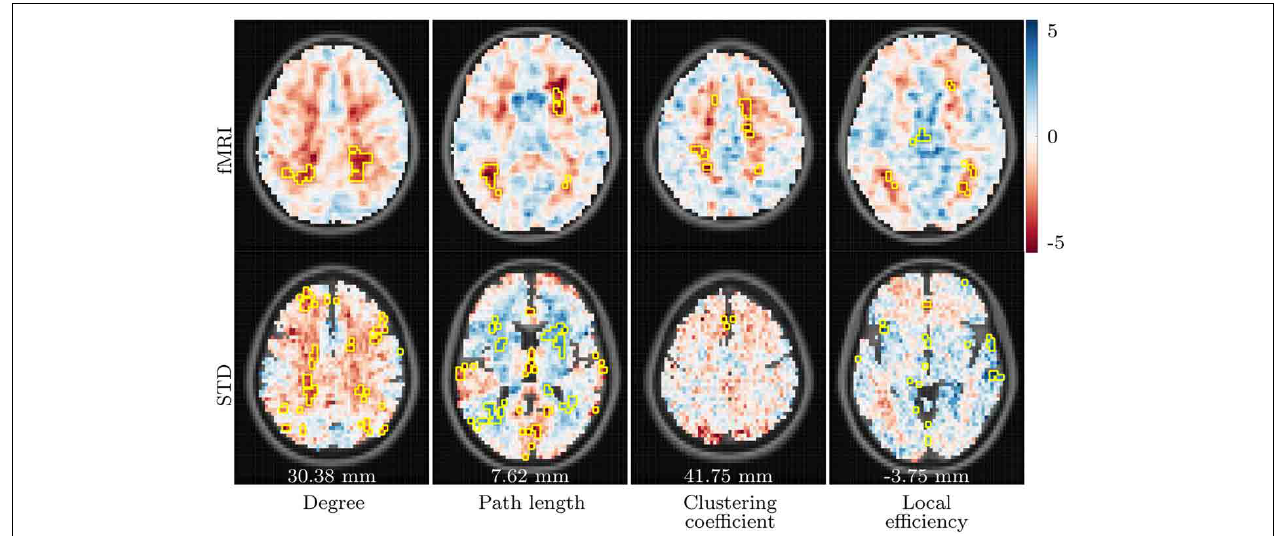
FIGURE 4 | t -values showing differences between the aged and aged with AD groups in fMRI and standard space resting state networks. Data for all network measures are shown for correlation threshold